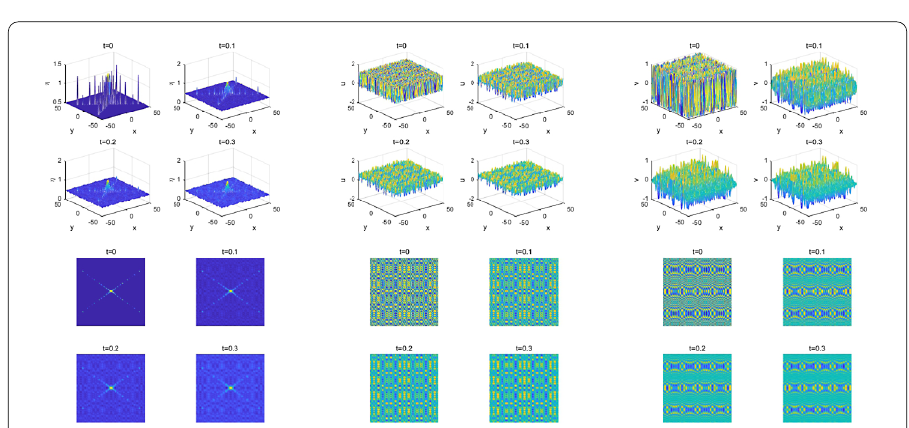
Figure 6 Numerical solution and pattern of Experiment 2, for initial conditions see Table 3